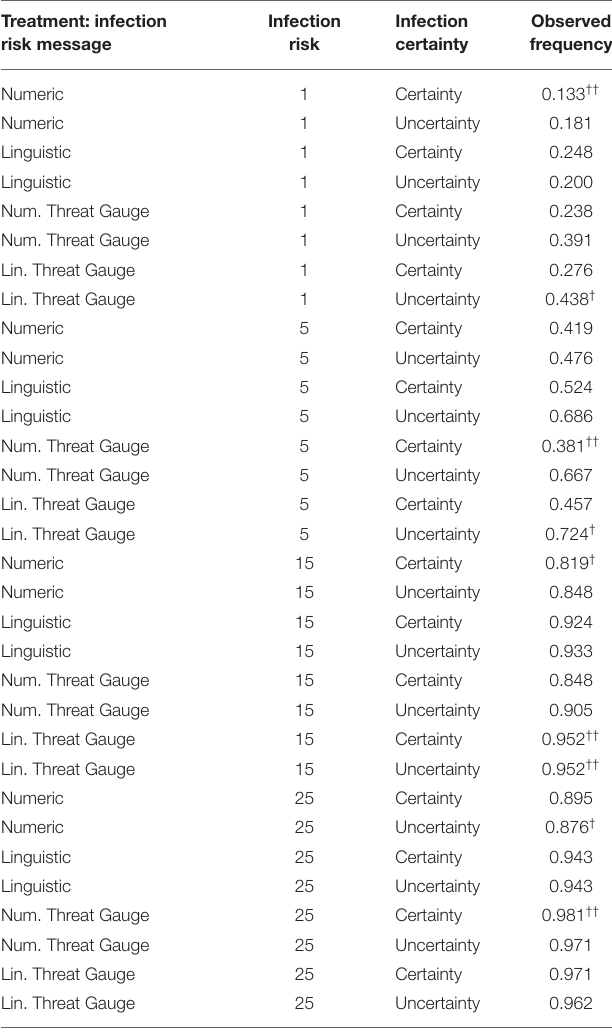
TABLE 1 | Frequency of observed use of the shower-in, shower-out biosecurity practice (compliance) by treatment and covariate interaction. Treatment: infection risk